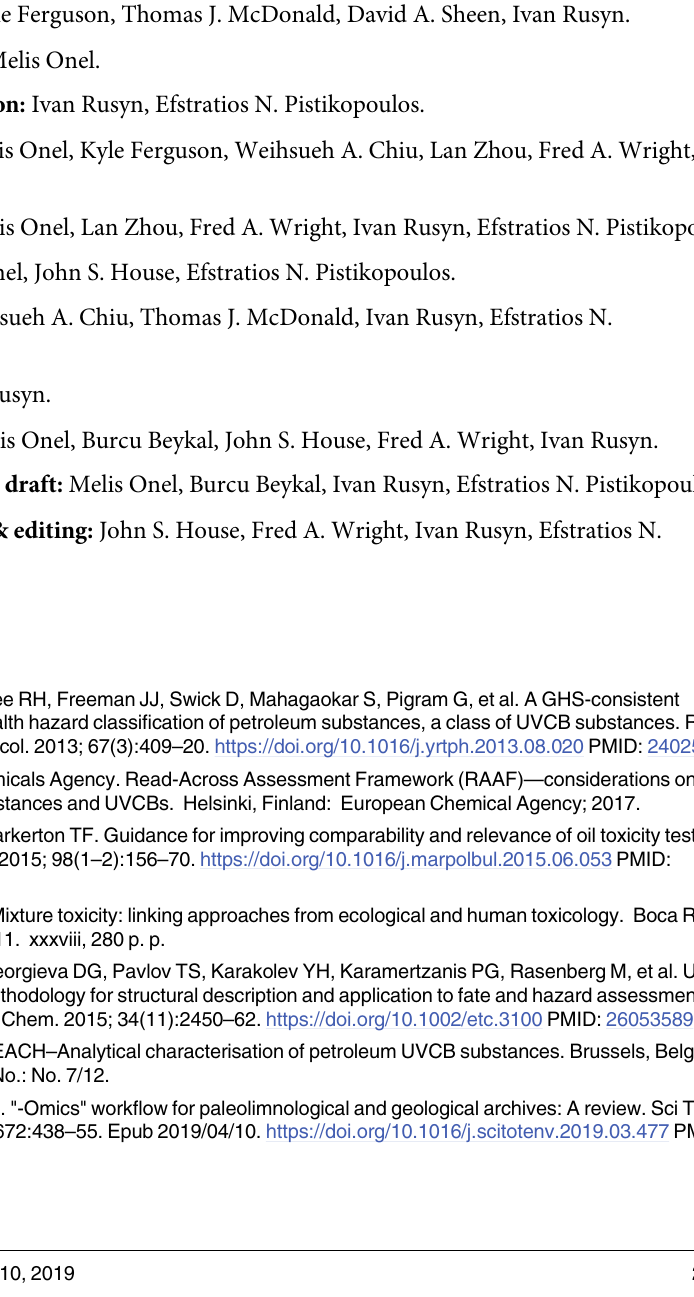
S4 Fig. Original and average confusion matrices of 1000 permutations for SRM substance